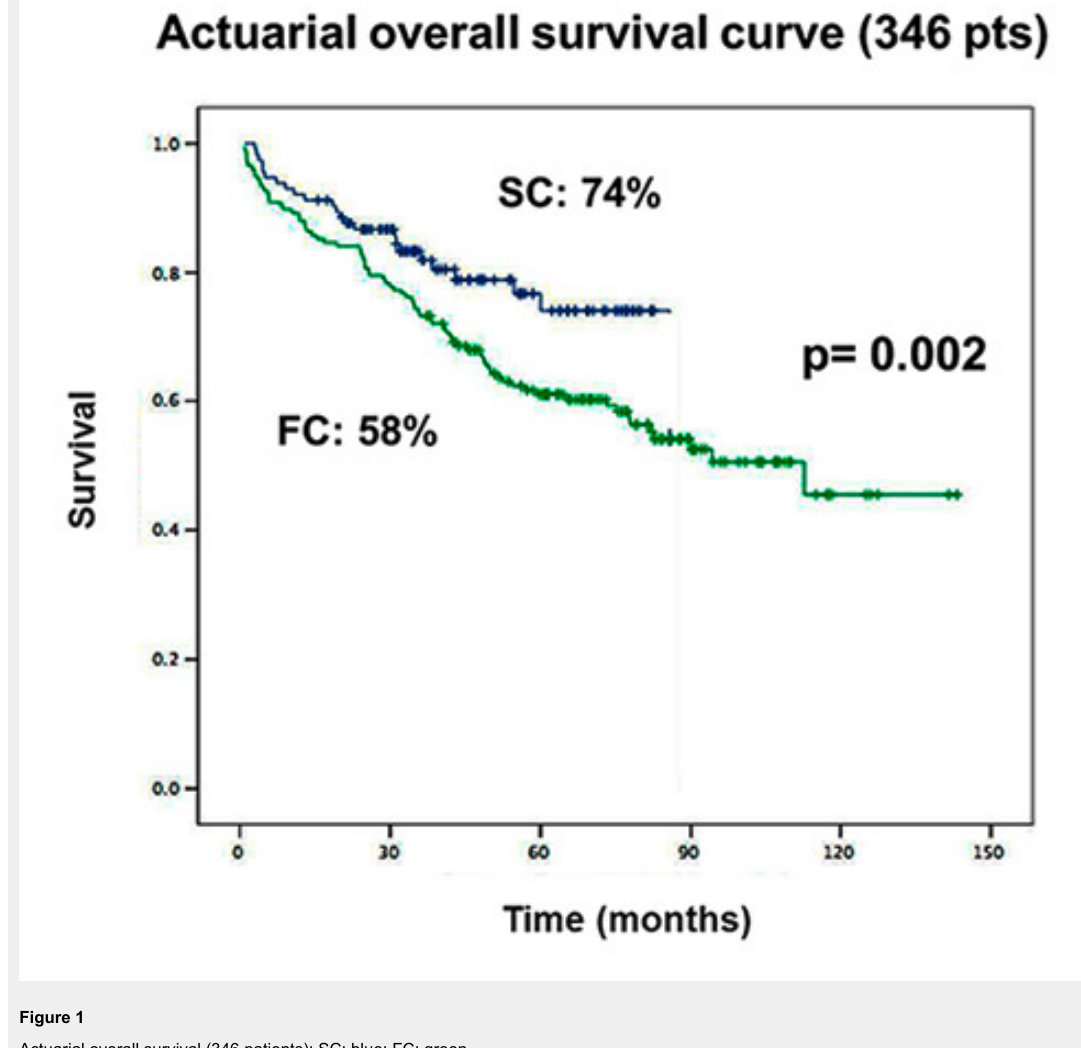
Figure 1 Actuarial overall survival (346 patients); SC: blue; FC: